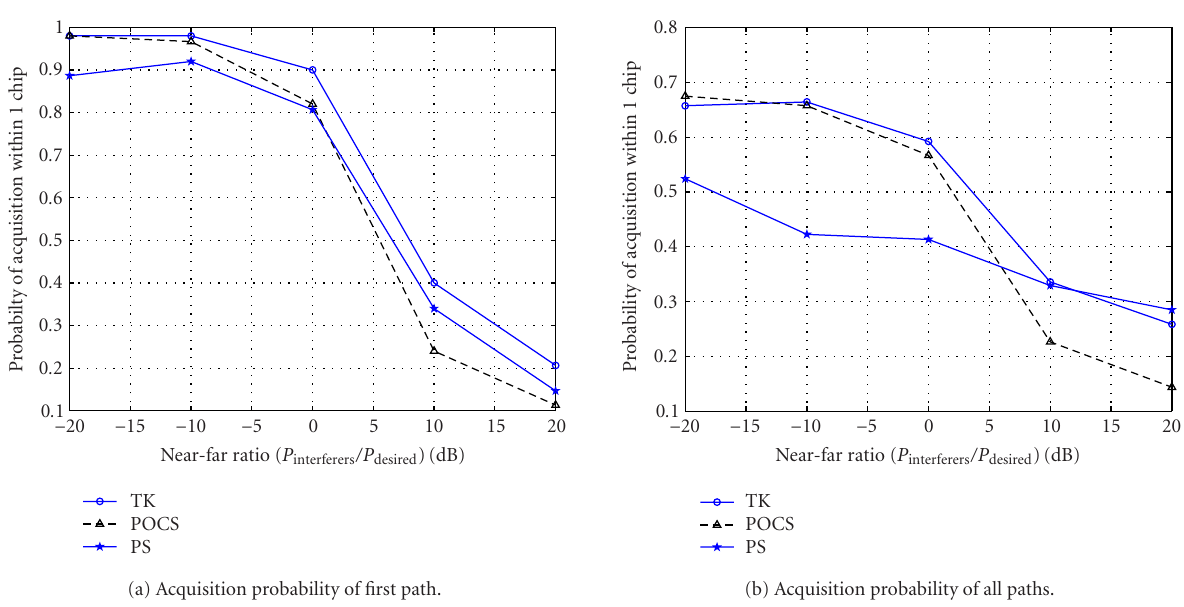
Figure 2: Probability of acquisition within 1 chip in closely spaced multipaths downlink WCDMA transmission using TK, POCS, and PS algorithms, N BS = 3, N u = 32, S F = 256, N s = 8, L = 5, and E b /N 0 =